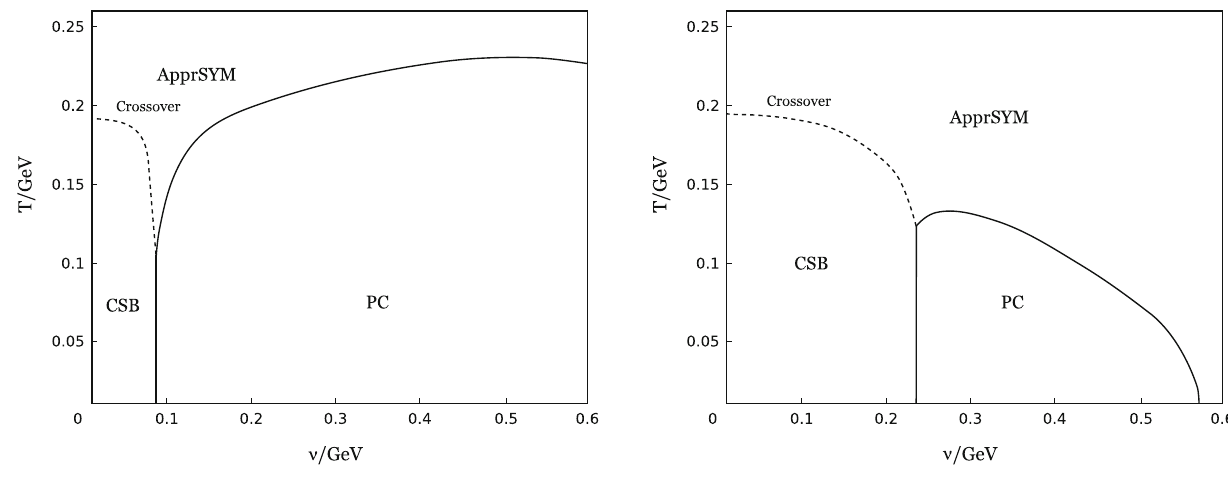
Fig. 7 The ( ν, T )-phase portraits at μ = ν 5 = 0MeV (left figure) and μ = 0MeV ,ν 5 = 200MeV (right figure)